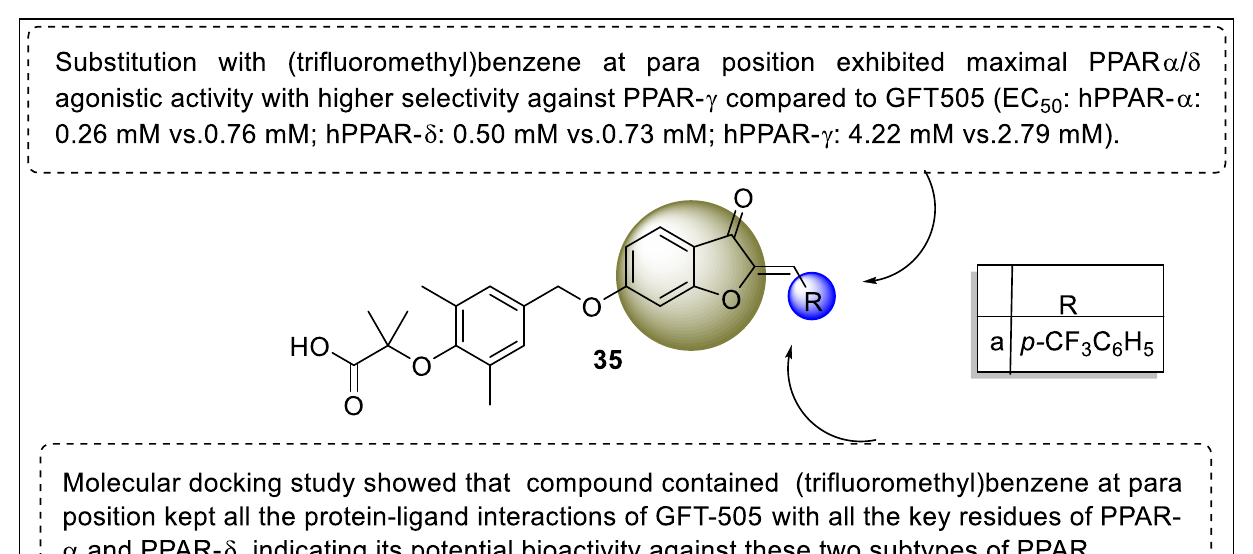
Figure 39. Structural activity relationship of Furan hybrids ( 35 ) as potent PPAR ligands.